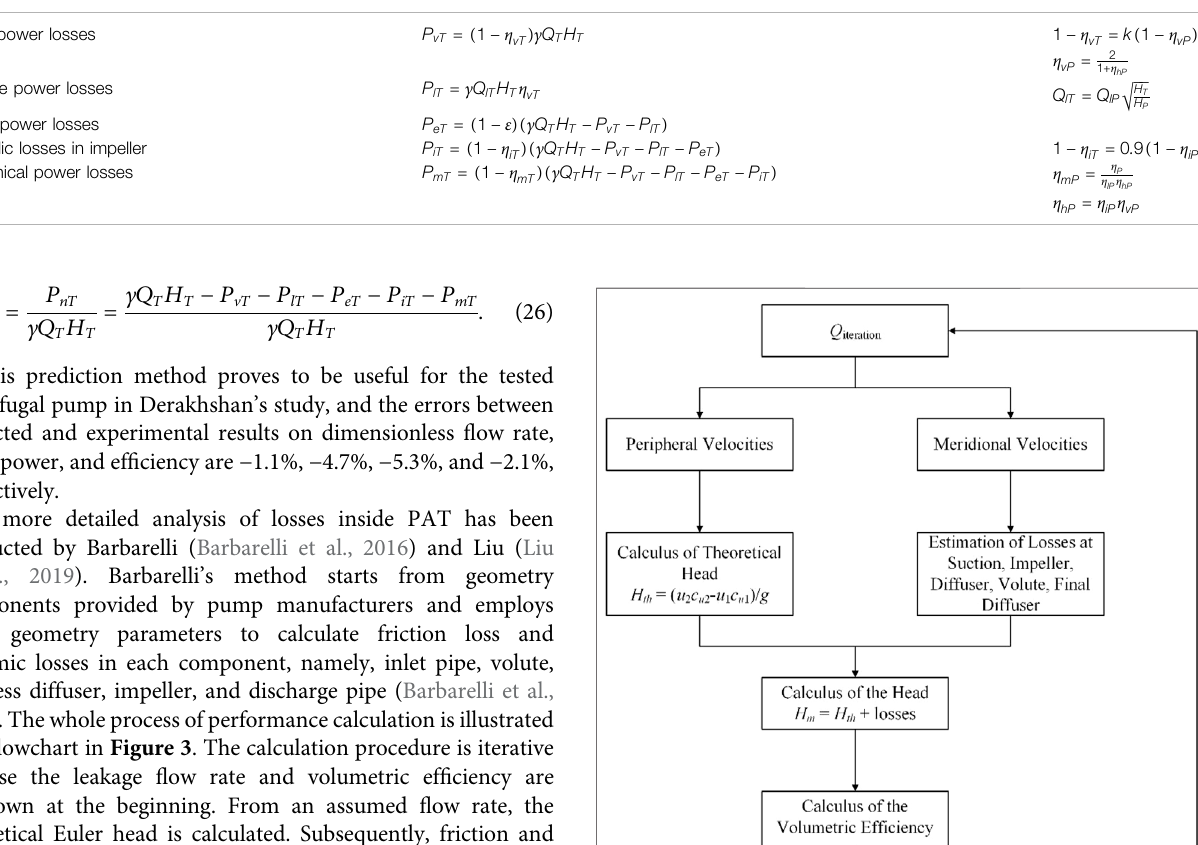
TABLE 5 | Formulas to calculate losses (Derakhshan and Nourbakhsh, 2008b). Loss